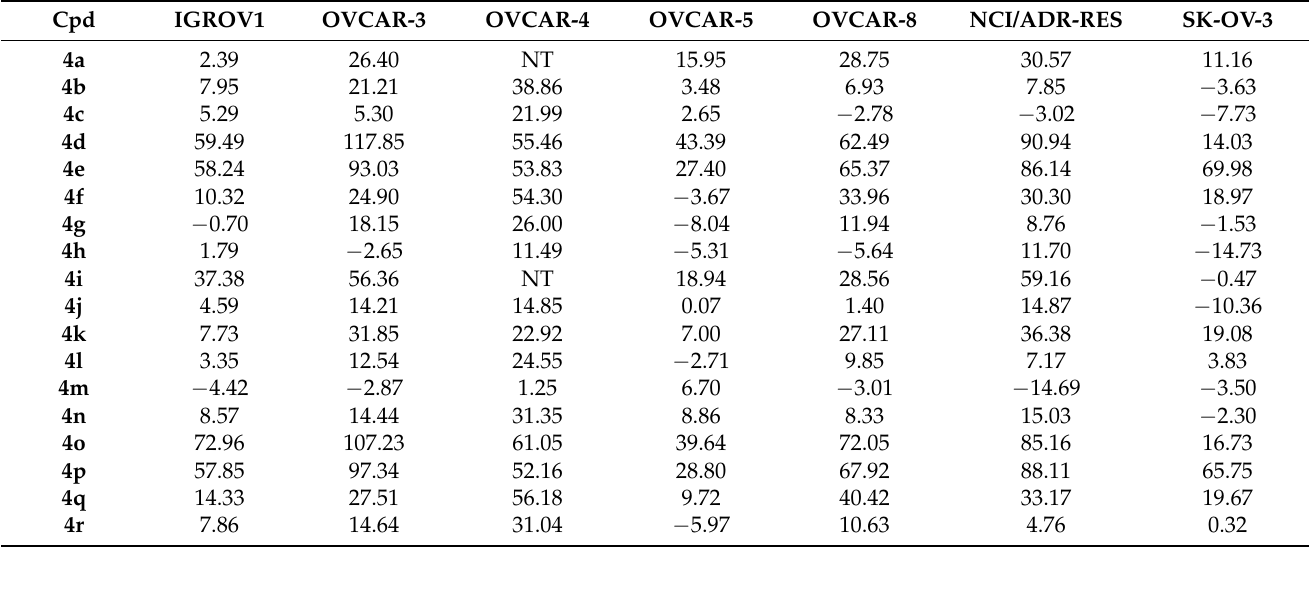
Table 10. Anti-proliferative activities (% growth inhibition) of the target compounds 4a – r against ovarian cancer cell lines.